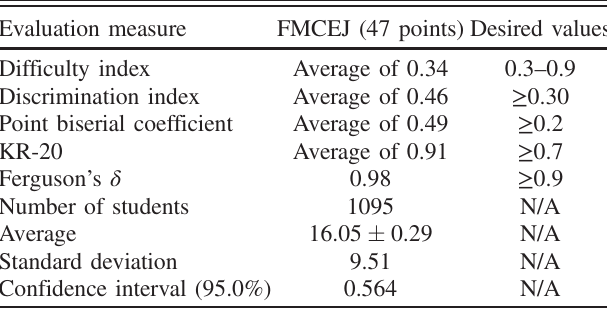
TABLE II. Evaluation of the FMCEJ written by Japanese